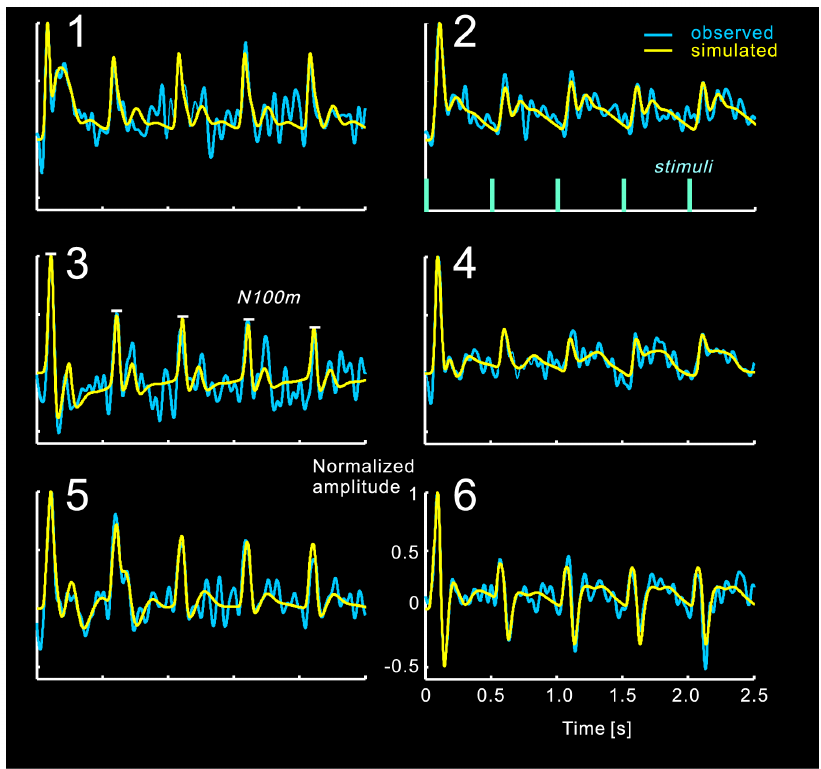
Figure 6. Observed and simulated (using LCCM) time courses of dipole activities.